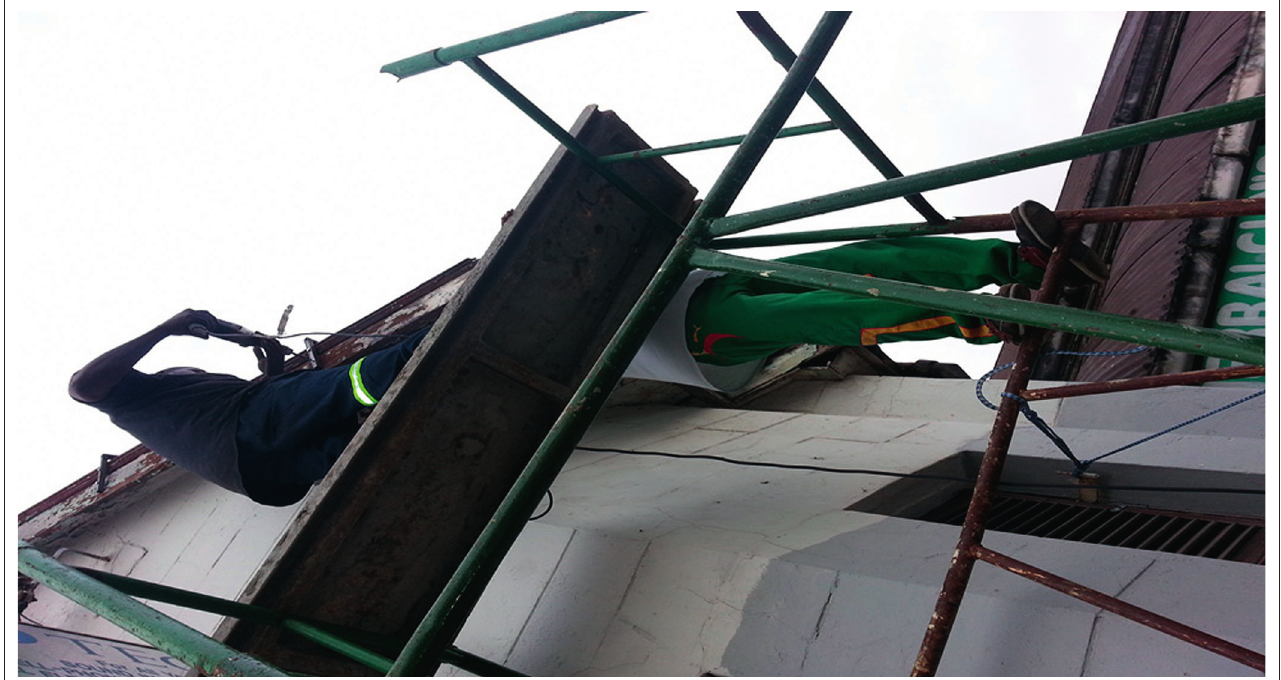
FIGURE 3: Mbali’s picture of her father at